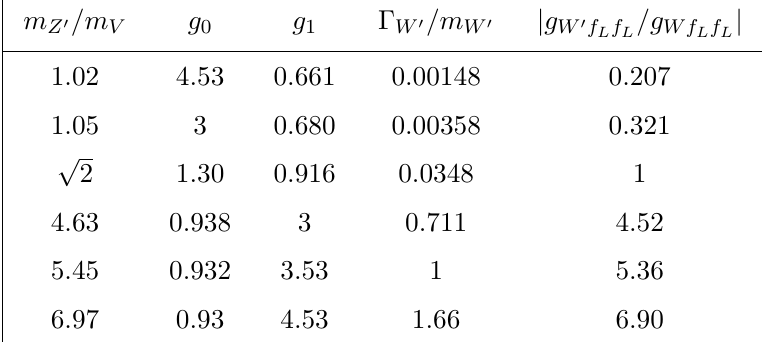
0 , g 1 , (cid:0) W 0 =m W 0 , and g W 0 f L f L =g Wf L f L given ratios of m Z 0 and m V .